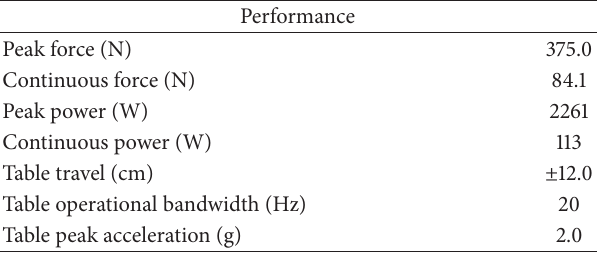
Table 2: Performance properties of the employed shaking table